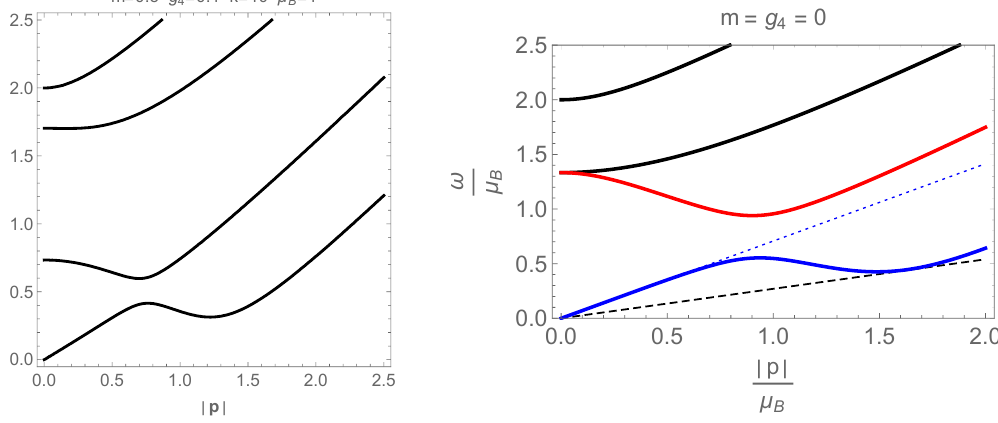
Figure 5 . Left : the physical spectrum for the massive case. Right: in the scale invariant situation, the dispersion relations have a universal form, independent of k and (cid:22) . The dotted blue line with p slope 1 = 2 matches the phonon velocity at low